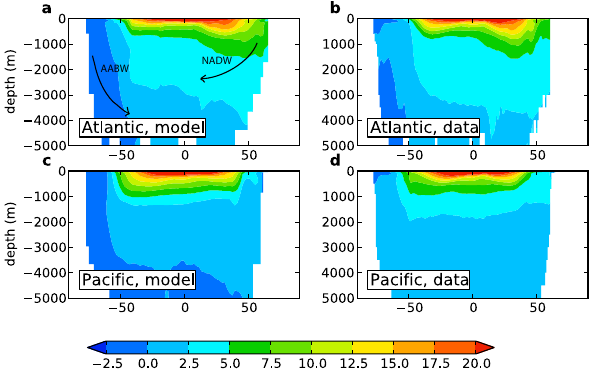
Figure 6. Zonal average of the temperature distribution ( ◦ C) in the ocean. Data from the World Ocean Atlas 2009 (Locarnini et al., 2010). North Atlantic Deep Water (NADW) and Antarctic Bottom Water (AABW) are indicated in panel (a) .